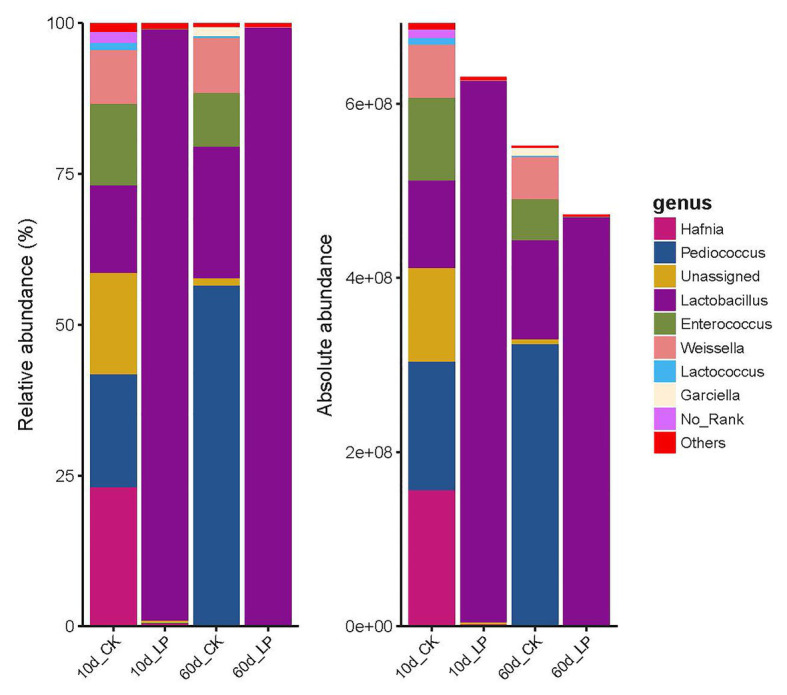
Barplots of bacterial communities in alfalfa silage illustrated by RQS and AQS. CK, control; LP, inoculated with L. plantarum A345. The numbers ahead of CK and LP stand for ensiled days of silage.